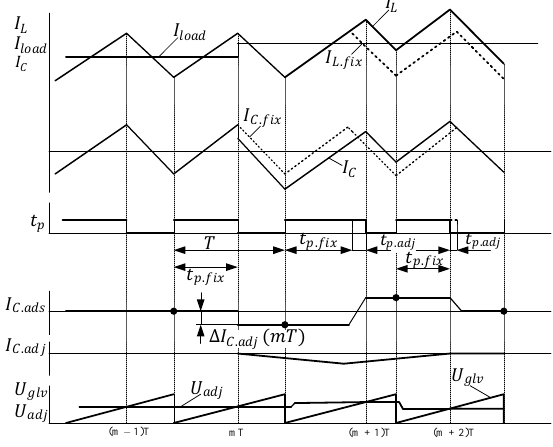
Figure 2. Timing diagrams of the buck converter From the general SVR process with PAM control, a stationary process and a control process can be distinguished. The first corresponds to the